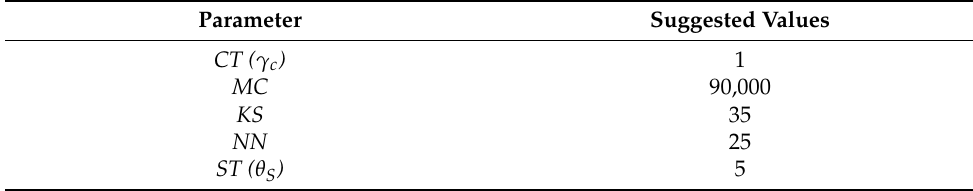
Table 7. Suggested values of region growing segmentation parameters.